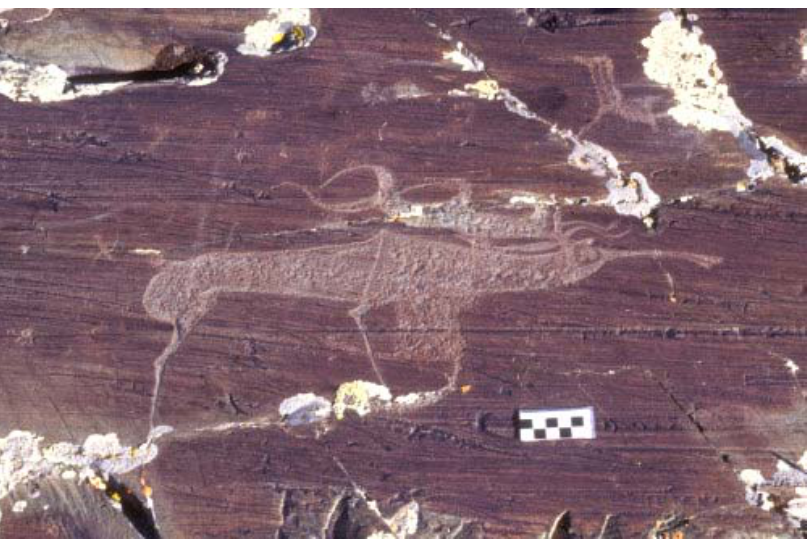
Figure 3. Stag (Late Bronze Age) pecked over Bronze Age bull. Upper Tsagaan Gol. (http://oregondigital.org/u?/maic,2208).